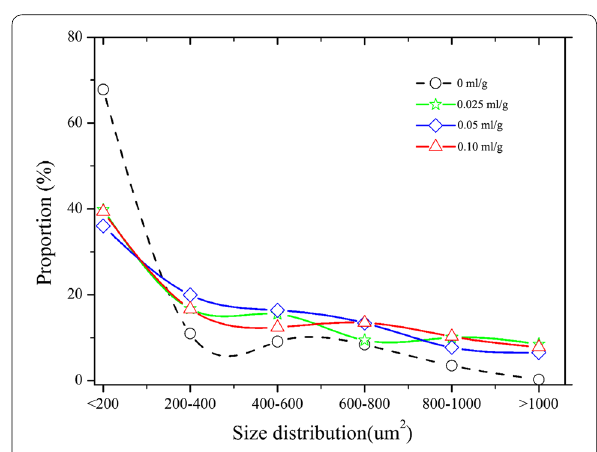
Fig. 3 Size distribution of starch granules in